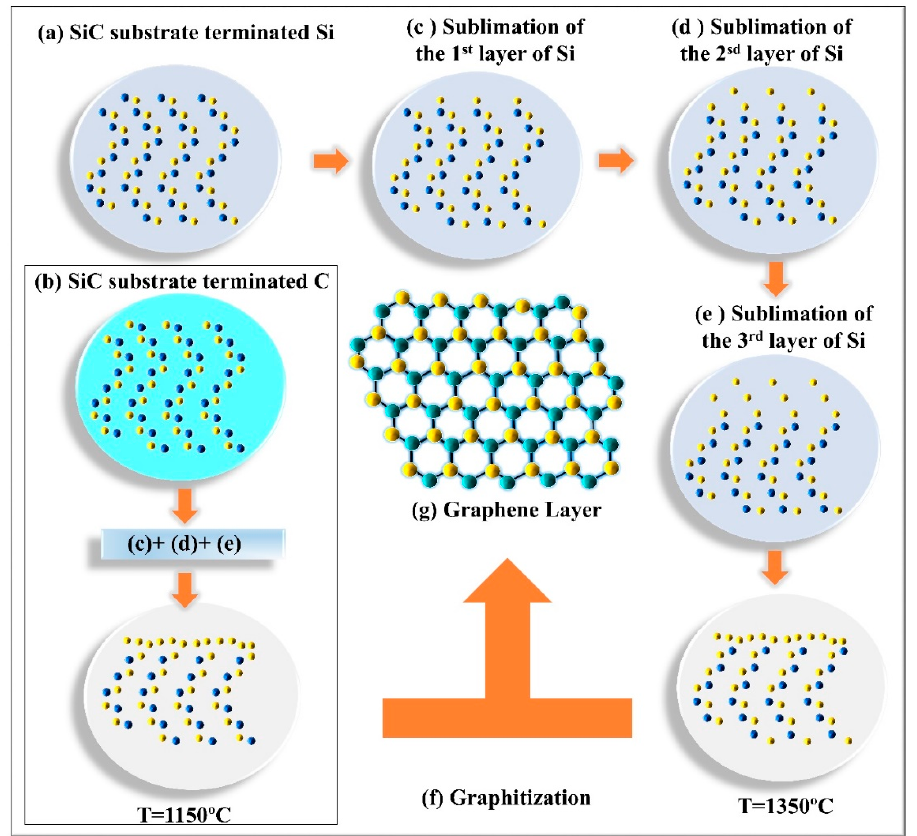
Figure 5. Epitaxial graphene growth on SiC substrate: ( a )—face terminated silicon (Si), ( b )—face terminated C, ( c )—sublimation of the first Si layer, ( d )—sublimation of the second Si layer, ( e )— sublimation of the third Si layer, ( f )—graphitization occurring at T = 1350 °C for the Si-terminated face and at T = 1150°C for the C-terminated face, ( g )—graphene layer formation.